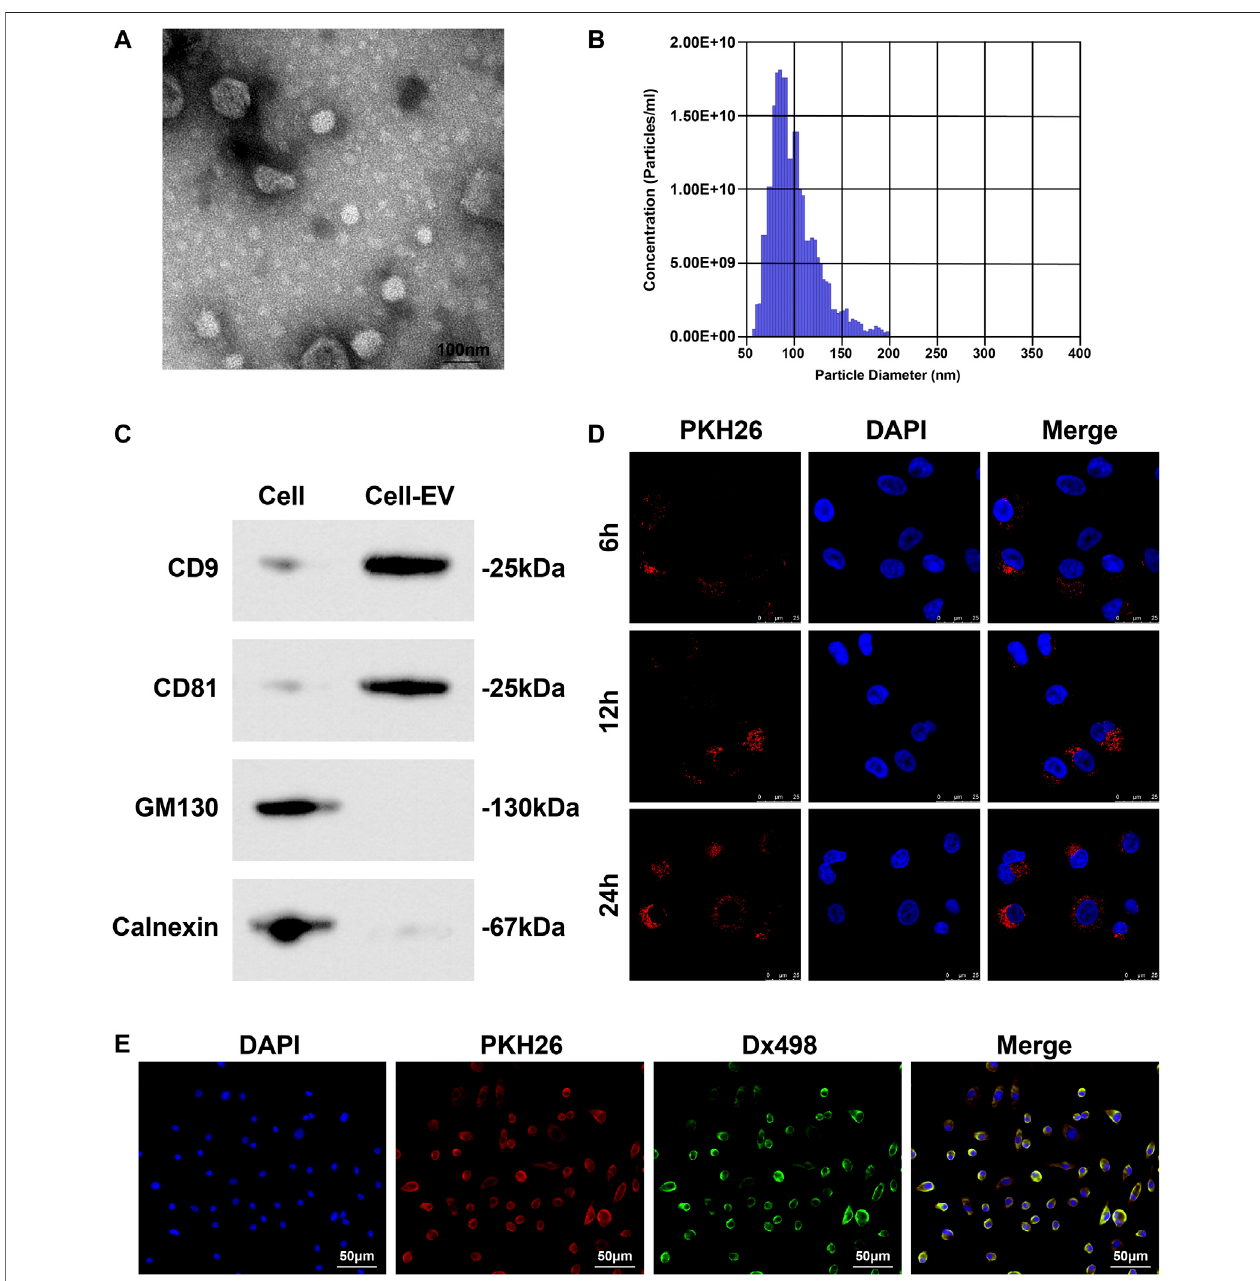
FIGURE 3 | EVs collection and identi fi cation. (A) Morphology and structure of EVs under TEM; (B) Concentration and diameter of EVs examined by TRPS; (C) EV markers (CD81, CD9, Calnexin and GM130) analyzed by Western blot; (D) Distribution of PKH26-labled EVs in HUVECs; (E) Co-localization of lysosome and EVs in